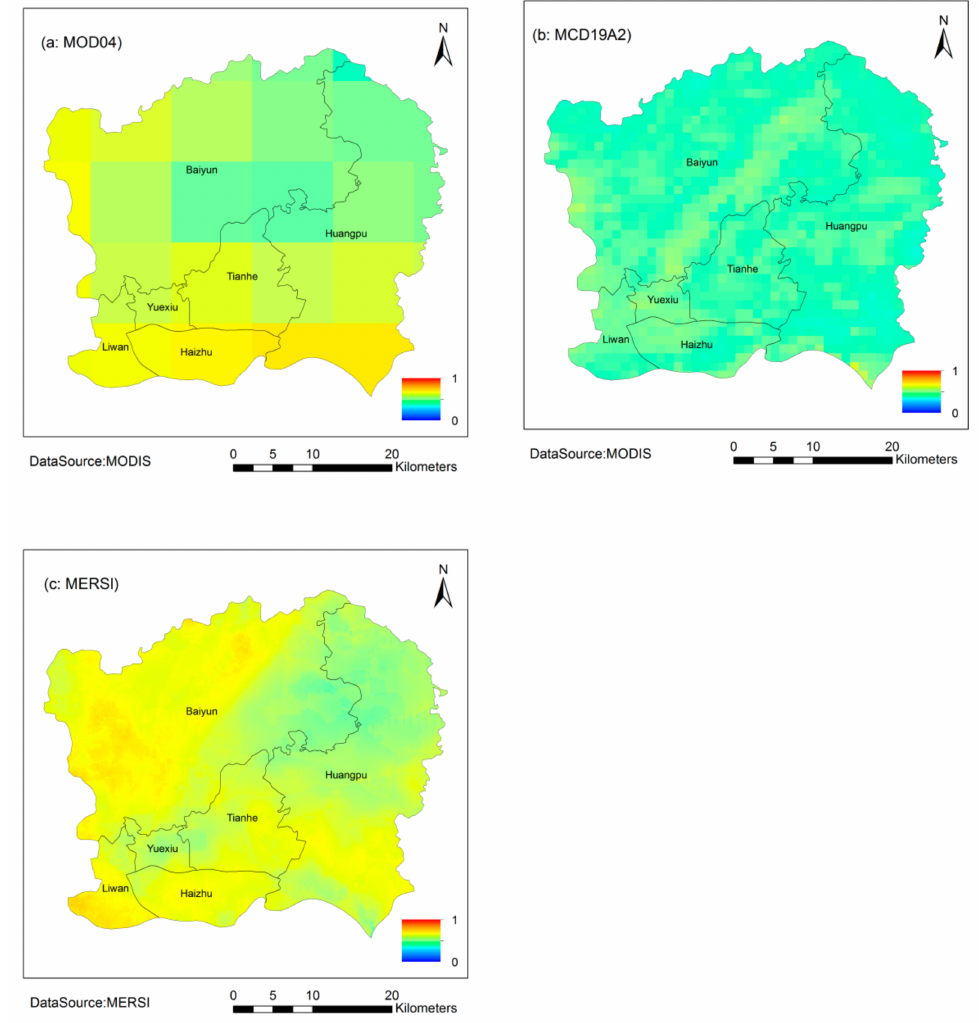
Figure 12. Yearly average AOD over Guangzhou from MERSI ( c ) and MODIS ( a ): MOD04, ( b ): (MCD19A2) in 2015.